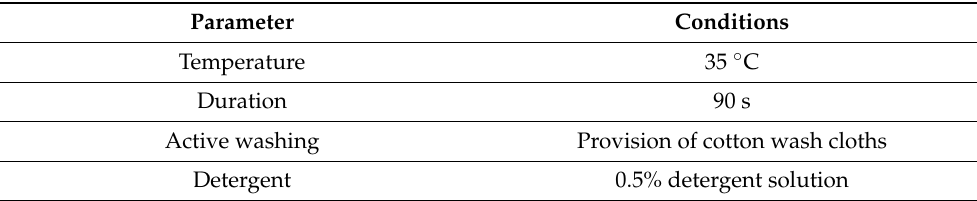
Table 1. The ‘ORCHIDS’ protocol for mass casualty decontamination using